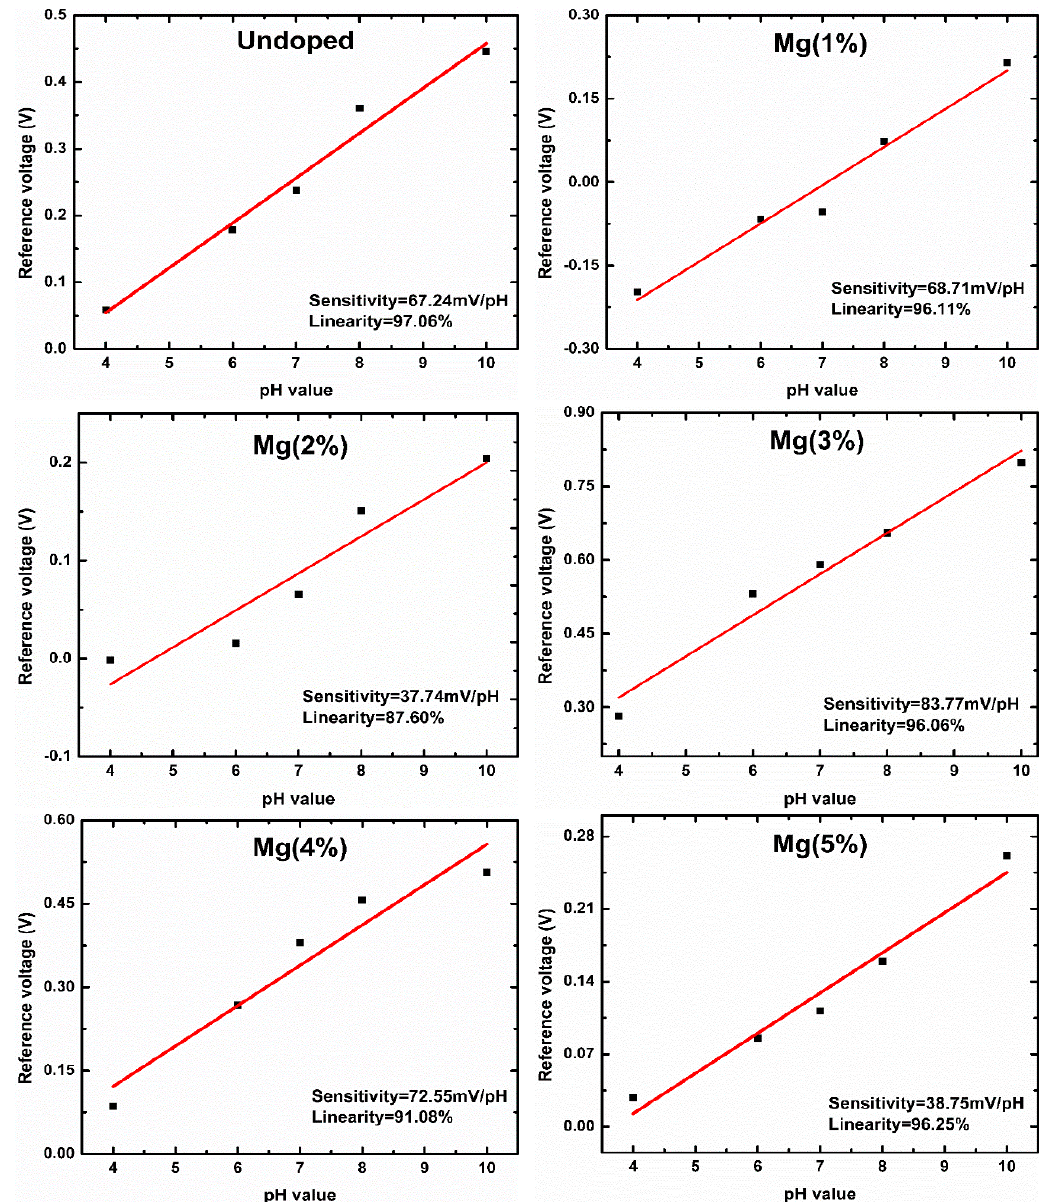
Figure 8. The pH sensitivity and linearity of the ZnO nanorods undoped and doped with different amounts of Mg. A high surface roughness is essential for improving the sensing performance of fab- ricated EIS sensors. This is due to the increase in surface sites; consequently, further pro- tonation and deprotonation will occur, increasing the potential at the oxide–electrolyte interface surface and resulting in higher sensitivity and linearity [61,66–70]. However, Mg ions can easily form because Mg has a low electronegativity (X = 1.31). Zn ions were sub- stituted for Mg ions through the doping process, likely modifying the Zn-O bonds and increasing the surface density [71]. Several groups reported using EIS-based ZnO thin films as sensors to detect pH in various ranges, as shown in Table 3.